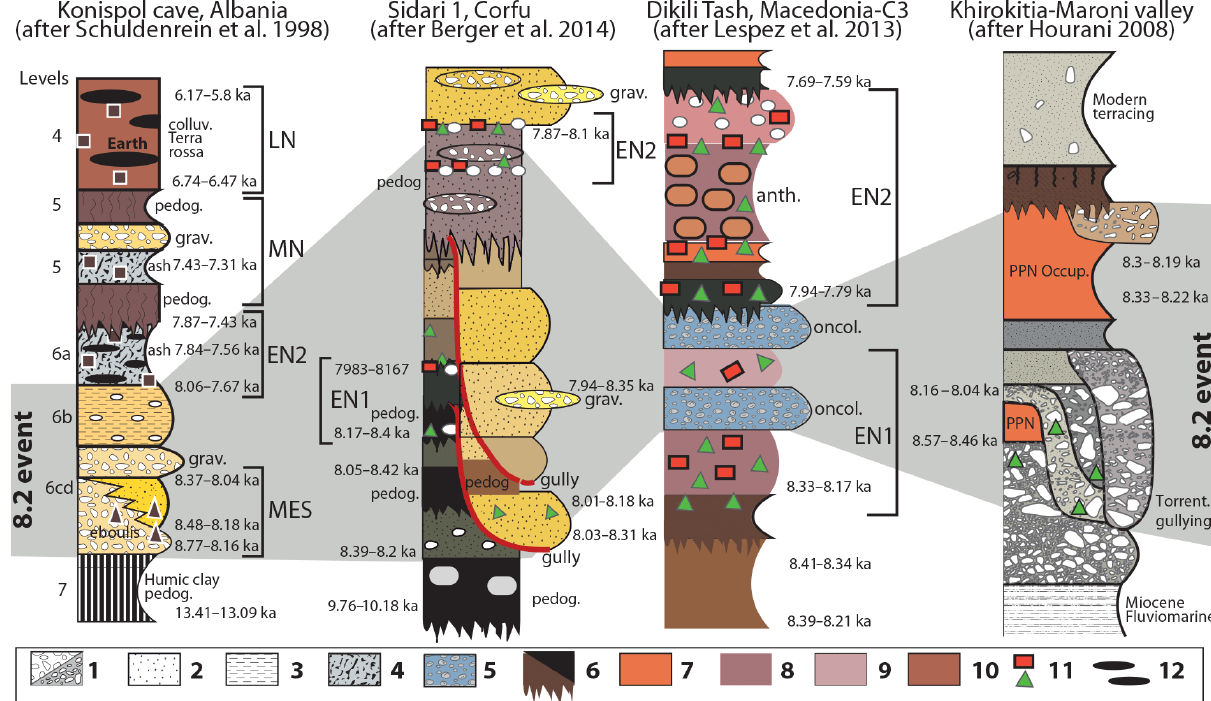
Figure 13. Morpho- and pedosedimentary contexts of four central to eastern Mediterranean early Neolithic sites (Konispol Cave, Sidari, Dikili Tash and Khirokitia) illustrating the 8.2ka event effects on the archaeological occupations. Geomorphological change applies on pure anthropogenic horizons or palaeosols, revealing an abrupt change in the local pedosedimentary functioning: 1, gravel layer; 2, sandy layer; 3, silty layer; 4, ashy layer; 5, oncolithic sands; 6, palaeosols; 7, in situ Neolithic layers; 8, slightly reworked Neolithic layer; 9, strongly reworked Neolithic layer; 10, red silty clay colluvial deposit (from Terra Rossa); 11, flints/ceramics; 12, earth radiocarbon dates are in